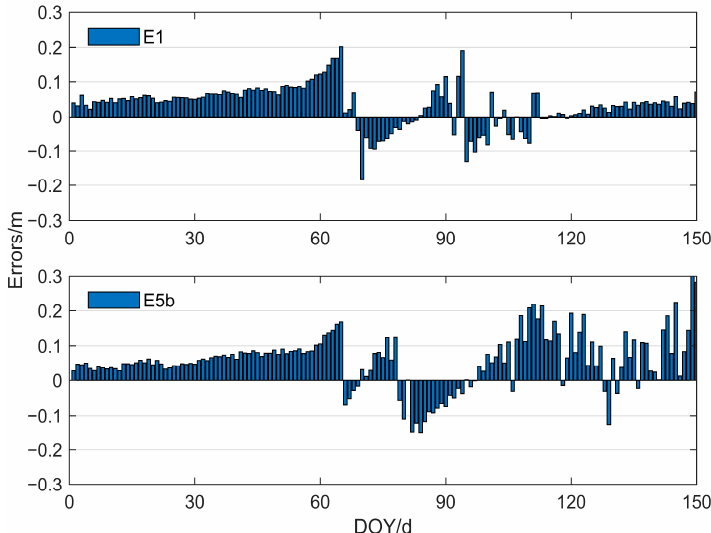
Figure 15. Retrieval errors of wheat height with Galileo.